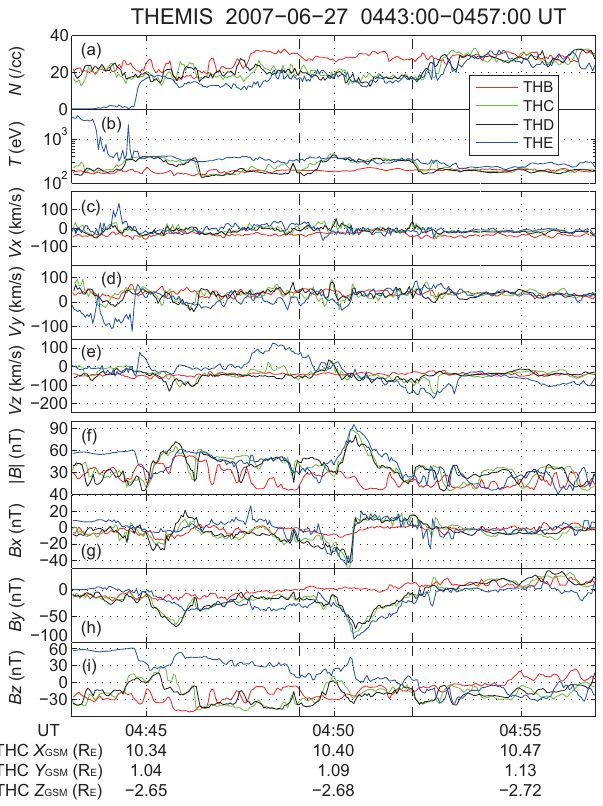
Figure 1. (a–e) Ion and (f–i) magnetic field data in GSM coor- dinates recorded by the ESA and FGM instruments, respectively, on board four (THB, THC, THD, and THE) of the five THEMIS probes during the interval 27 June 2007, 04:43–04:57UT. THC and THD data during the interval 04:49:05–04:52:05UT, sandwiched between the two vertical dashed lines, are used for the 3-D magne- tohydrostatic